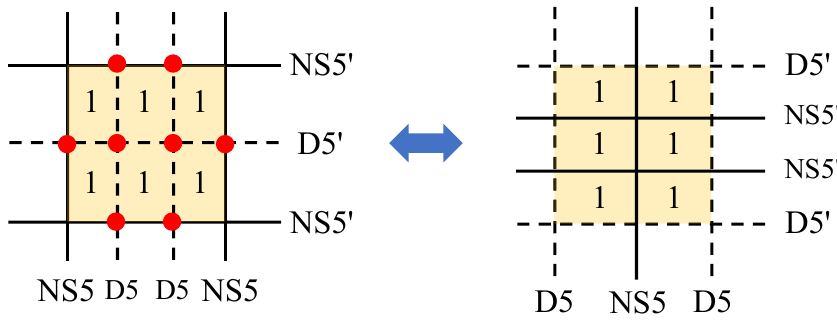
= (0 , 4) U(1) gauge theory with two charged N